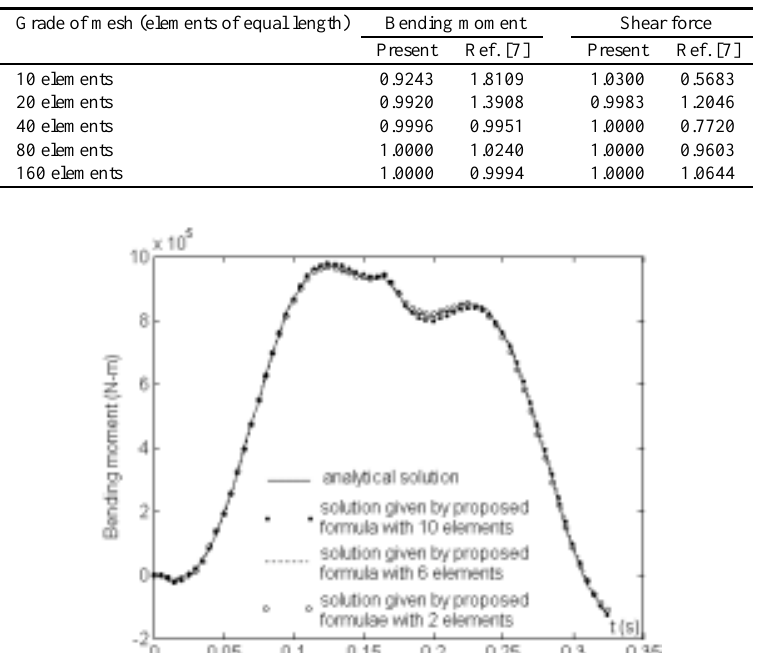
Fig. 9. Time histories for bending moment at the midpoint cross-section of beam with analytical solution, and the solutions given by the proposed formula with 2, 6 and 10 elements. with 2 PL 3 y ( x, t ) = ¯ mπ